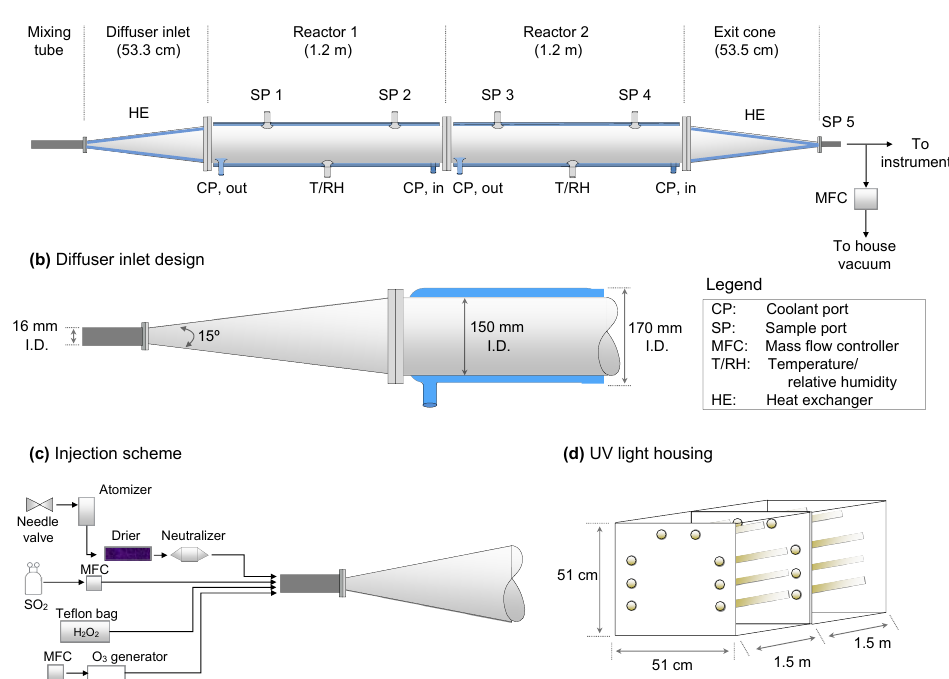
Figure 1. Overall schematic of the Caltech Photooxidation Flow Tube (CPOT). (a) The inlet design. (b) The injection scheme. (c) Schematic for the housing chamber. (d) UV